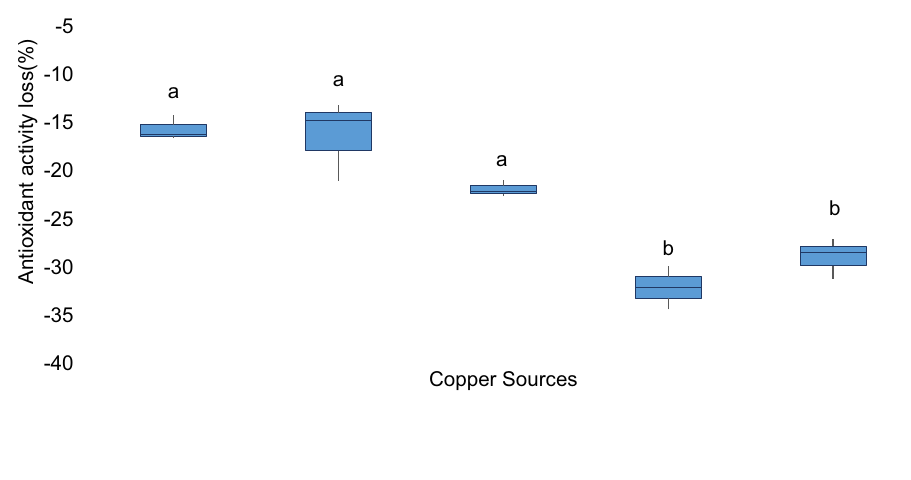
Fig. 2 The effect of the various Cu sources on the stability of α-tocopherol acetate over a nine-week period. Data are a means of triplicate experi- ments. Average values lacking a common superscript differ in statistical significance according to one-way ANOVA and separation by Tukey’s test ( p ≤